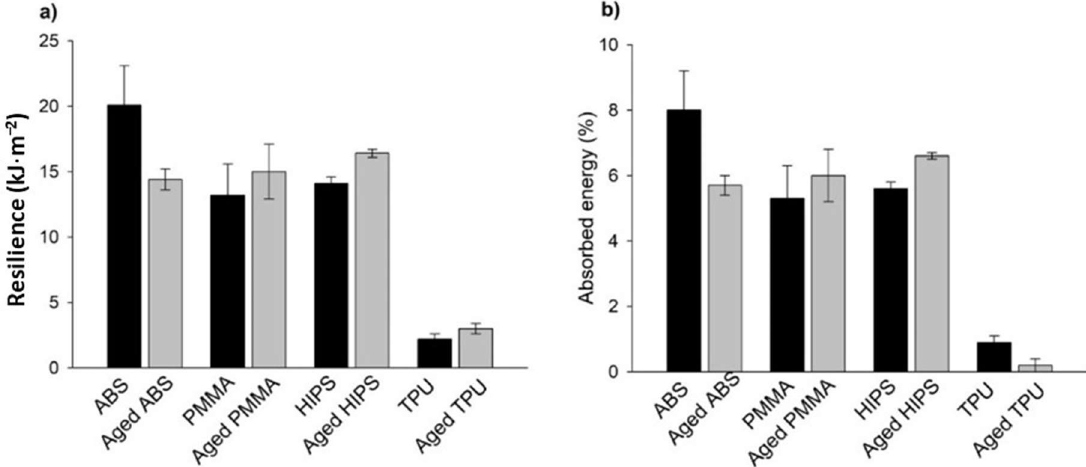
Figure 4. ( a ) Resilience and ( b ) absorbed energy of the printed mono-material specimens, which were obtained using transverse impact tests.